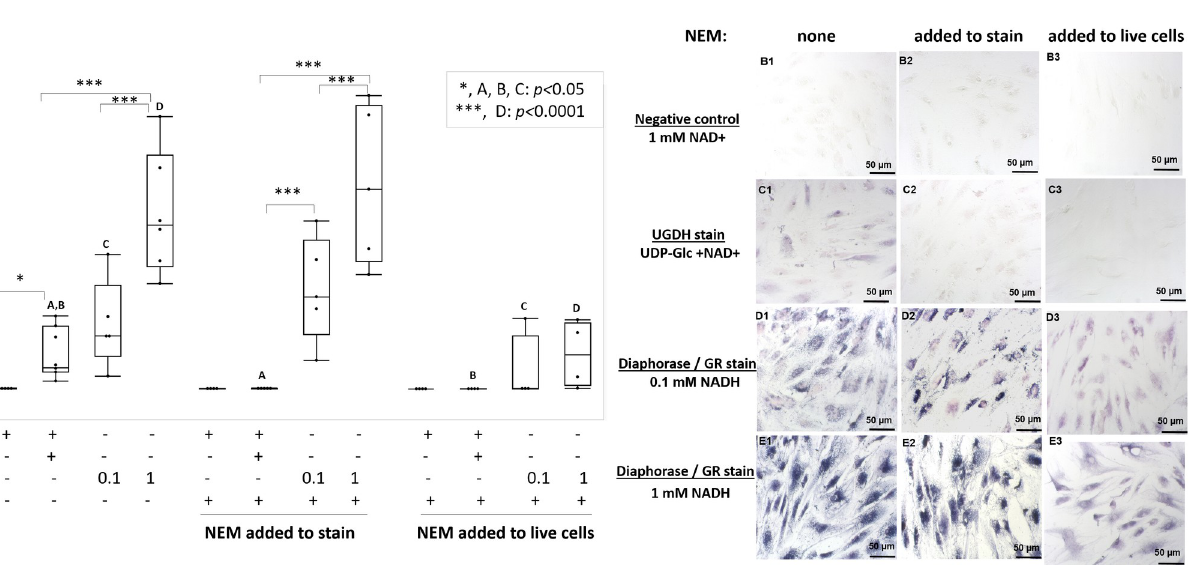
PLOS ONE | https://doi.org/10.1371/journal.pone.0274420 September 15,